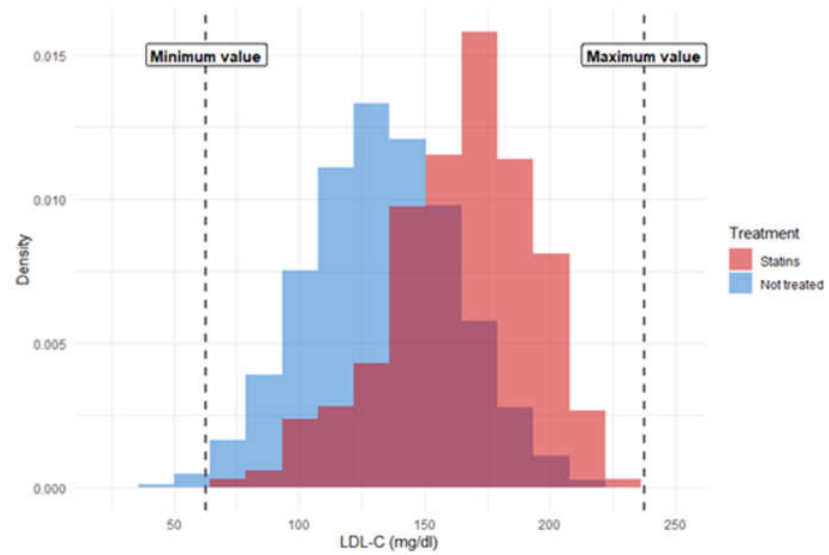
Figure 1. Example of sample restriction for low-density lipoprotein cholesterol.